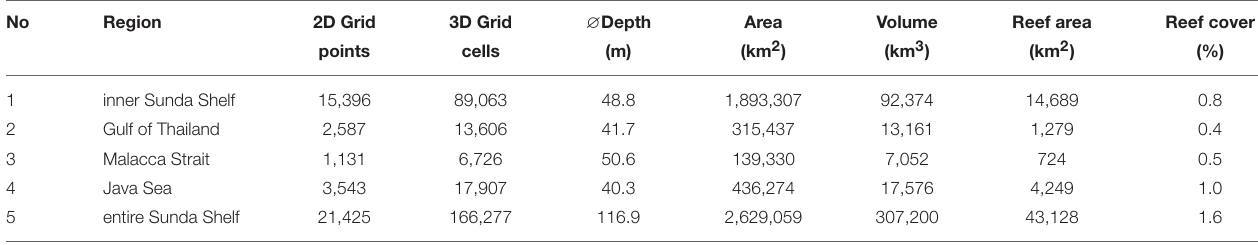
TABLE 1 | Some geometric data about the sub-domains mentioned in the